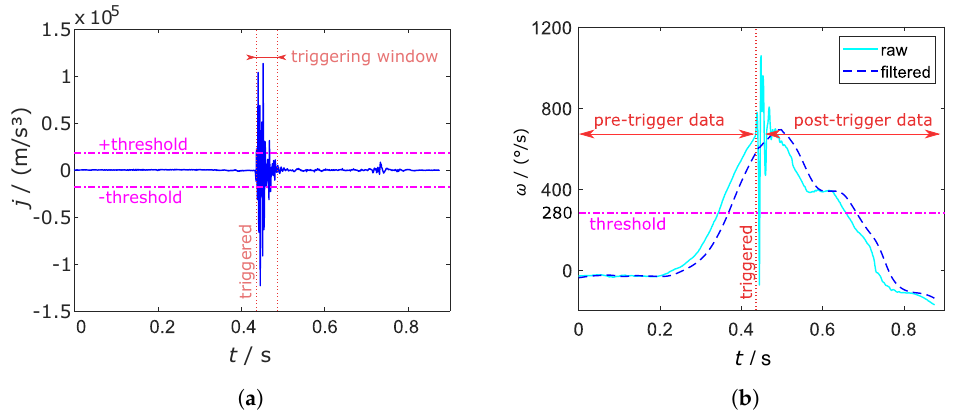
Figure 4. Jerk j ( a ) and angular velocity in y-direction ω y raw and filtered ( b ) of a forehand topspin compared to the trigger thresholds. The time delay of the filtered ω y is clearly